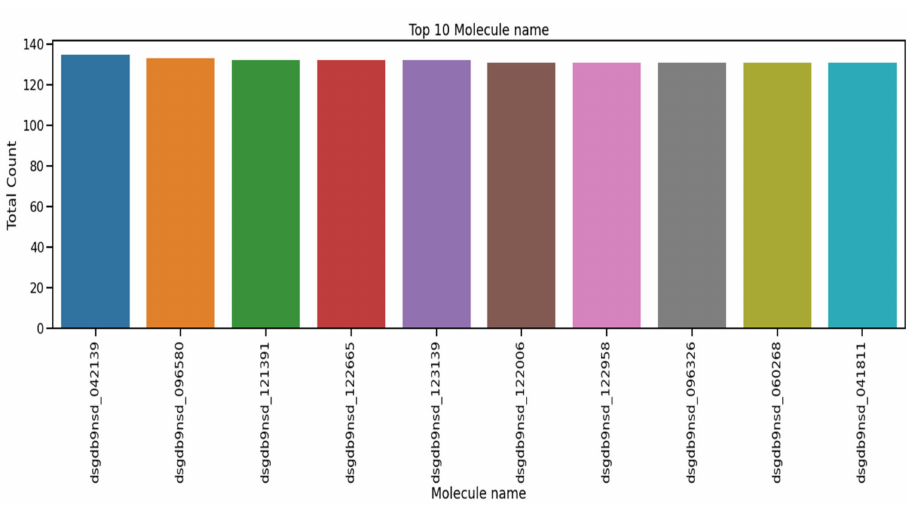
Figure 3. The coupling type of molecular property.